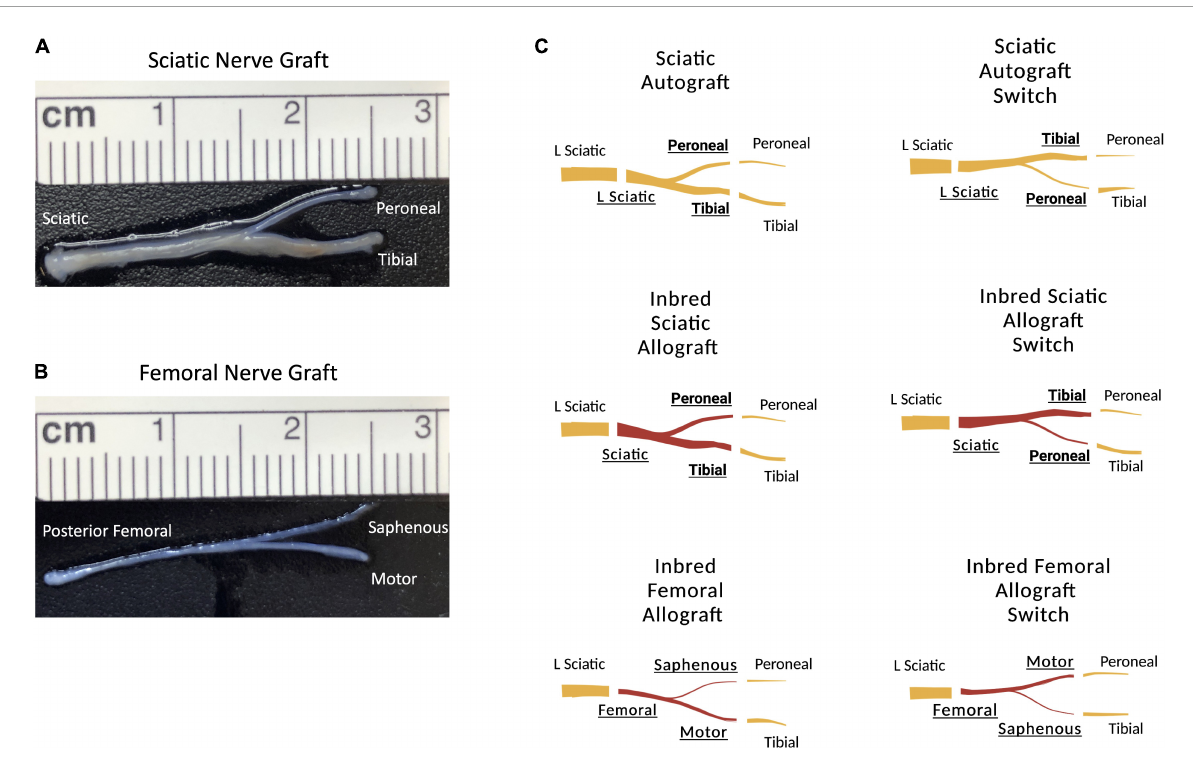
FIGURE1 Schematic representation of the surgical groupings and graft types. (A) 2.5 cm sciatic nerve graft with peroneal and tibial branches. (B) 2.5 cm femoral nerve graft with saphenous and motor branches. (C) Schematic representation showing the orientation of the grafts. Original sciatic nerve orientation with the peroneal branch of the graft sutured to the distal peroneal site and the tibial branch of the graft sutured to the distal tibial site. The sciatic switch groups with the opposite, with the peroneal branch of the graft sutured to the distal tibial site and the tibial branch of the graft sutured to the distal peroneal site. Inbred sciatic allografts depicting the same orientations as shown for sciatic autografts. Inbred femoral allografts in the original orientation with the motor branch of the graft sutured to the distal tibial site and the saphenous branch of the graft sutured to the distal peroneal site. In the switched orientation, the motor branch of the graft was sutured to the distal peroneal site and the saphenous branch of the graft was sutured to the distal tibial